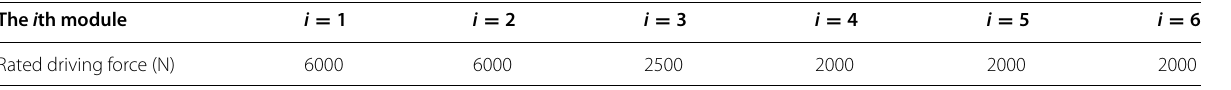
Table 1 Rated driving force of the electric cylinder in each module of the HRETR The i th